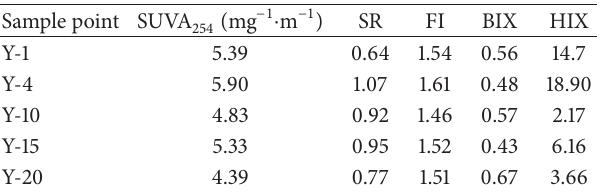
Table 5: Results of UV-Visible spectroscopy and EEM fluorescence